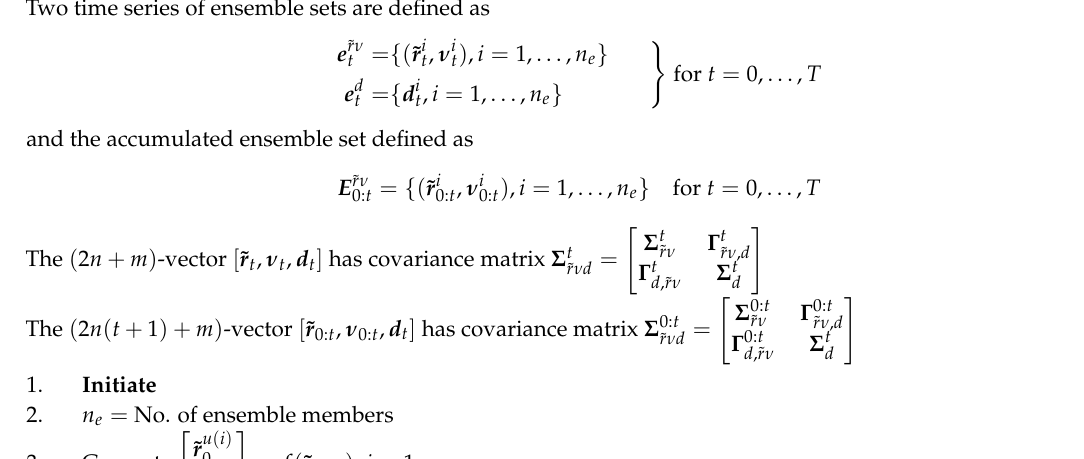
Algorithm A2 Selection Ensemble Kalman Smoother